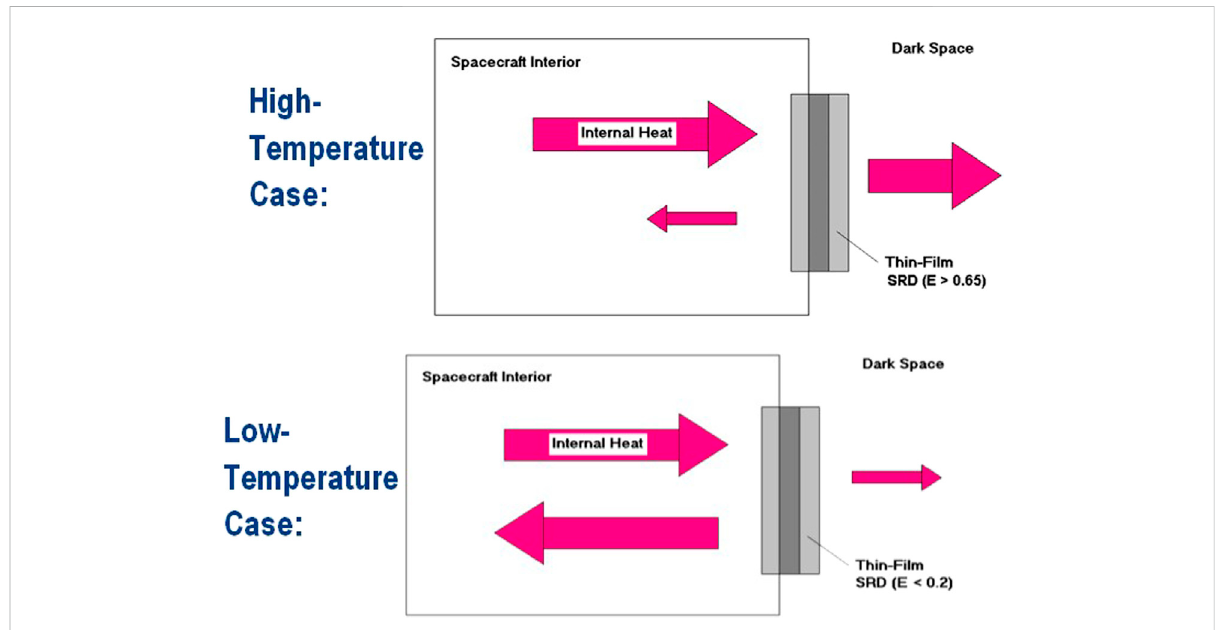
FIGURE 1 Principle of the smart radiator device- The change in emissivity permits to dissipate the heat at high- temperature and to keep the heat inside spacecraft at